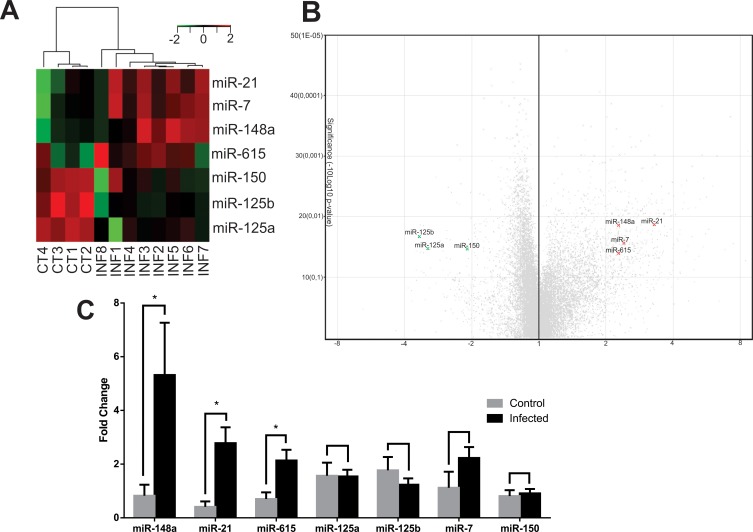
Differentially expressed miRNAs in SL of dogs with CanL.(A) Representation of the 7 miRNAs differentially expressed in SL of dogs with CanL in comparison to healthy dogs. Heat map lines represent individual miRNAs and the columns represent individual samples (eight dogs with CanL and four control dogs). Color scale represents normalized expression levels of miRNAs in the two conditions on the log2 scale; red denotes up-regulation and green denotes down-regulation. (B) Volcano plot. On the left are miRNAs with negative expression (green) and miRNAs with positive expression (red). Analysis of variances (ANOVA) was used between groups, and significance was considered at Fold Change greater than +/-2 and p<0.05. (C) Expression of miRNAs in the infected and control groups was quantified by real-time PCR in SL. Data represent mean of miRNA expression + standard error of the mean. Asterisks represent significance (p<0.05) by Mann-Whitney test.